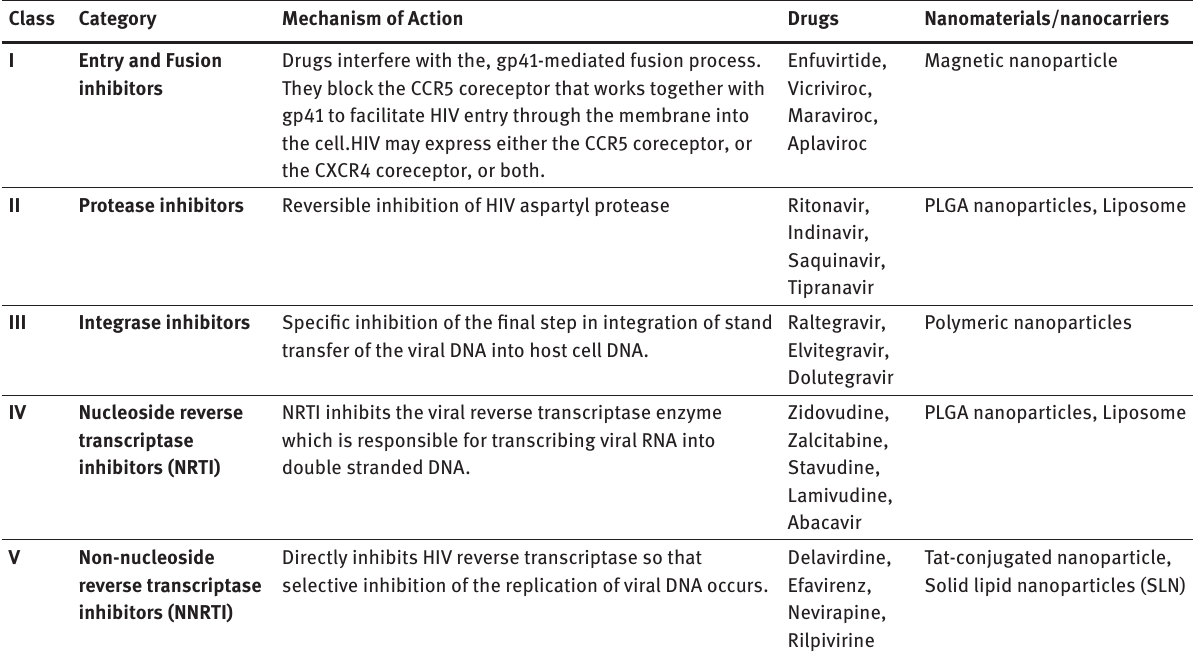
Table 1: Nanotechnology based CNS delivery of antiretroviral drugs. Class